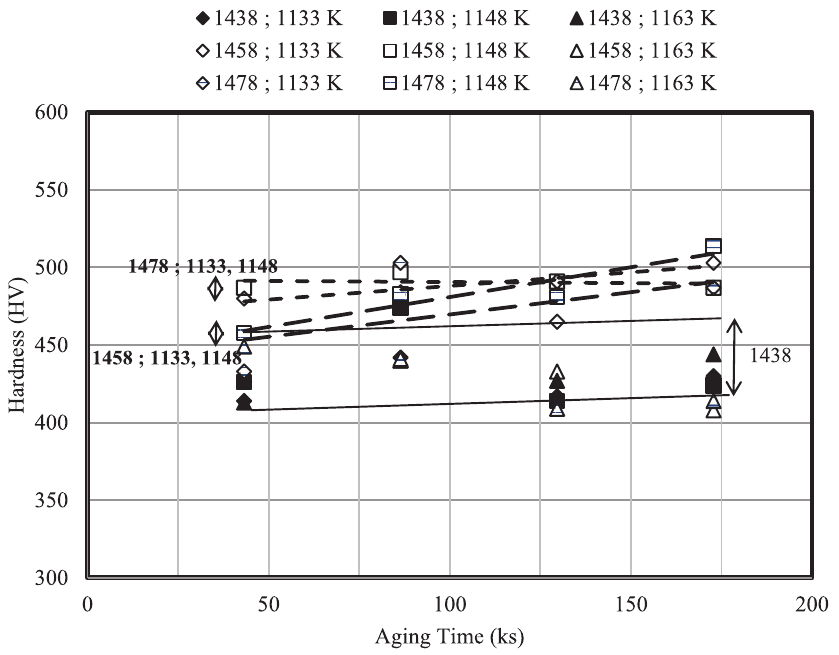
Fig. 7: Average hardness at various aging times of each aging temperature after solutionizing temperatures of 1,438, 1,458 and 1,478 K